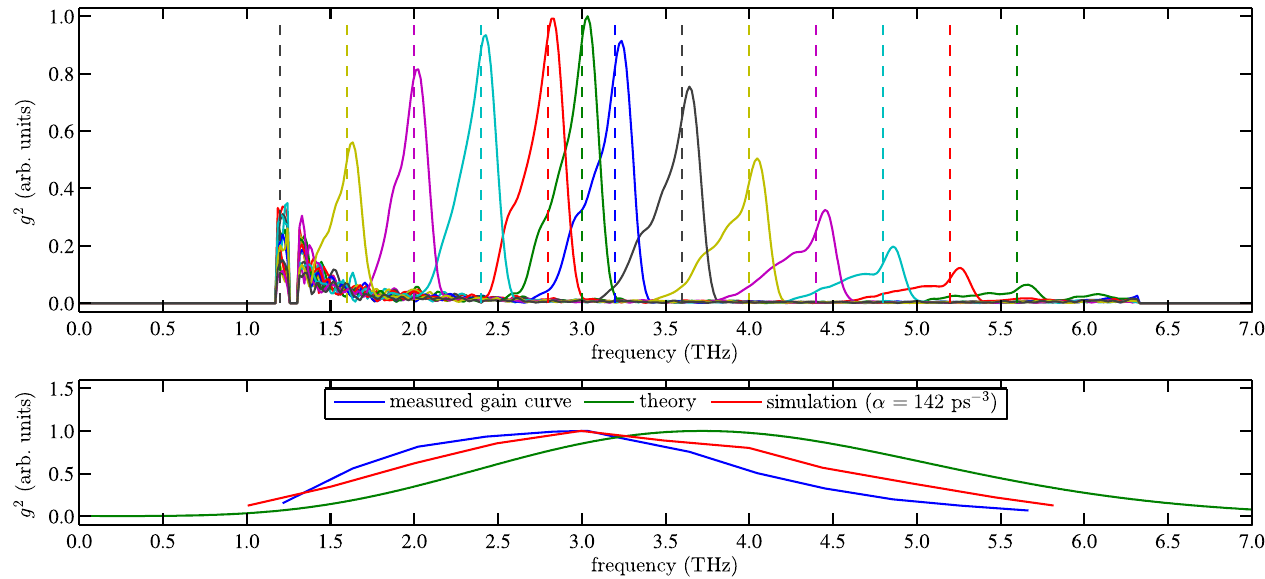
FIG. 7. Top: measured narrowband THz form factors (solid lines) and corresponding laser modulation frequencies (dashed, see text for details). Bottom: gain curves extracted from the measured (top) and simulated form factors (see Fig. 5) and according to theory (see Fig. 2).